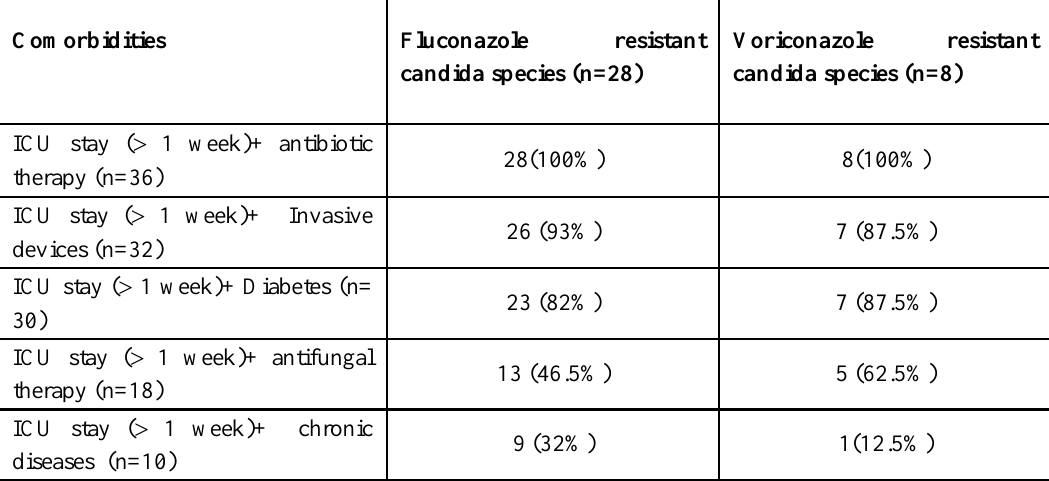
Table 6. Different risk factors and associated comorbidities in azole resistant candida